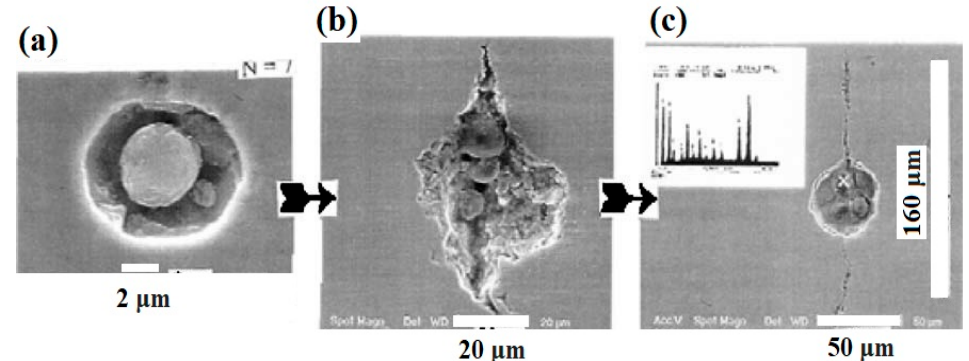
Figure 5. ( a ) Pit formation from an inclusion in X65 pipeline steel, ( b ) SCC crack initiation from a pit and ( c ) EDS analysis on the inclusion showing the existence of Na, Mg, Al, Si, P, S, Cl, K, and Ca elements [27]. Reproduced with permission from [27], Springer Nature, 2009.